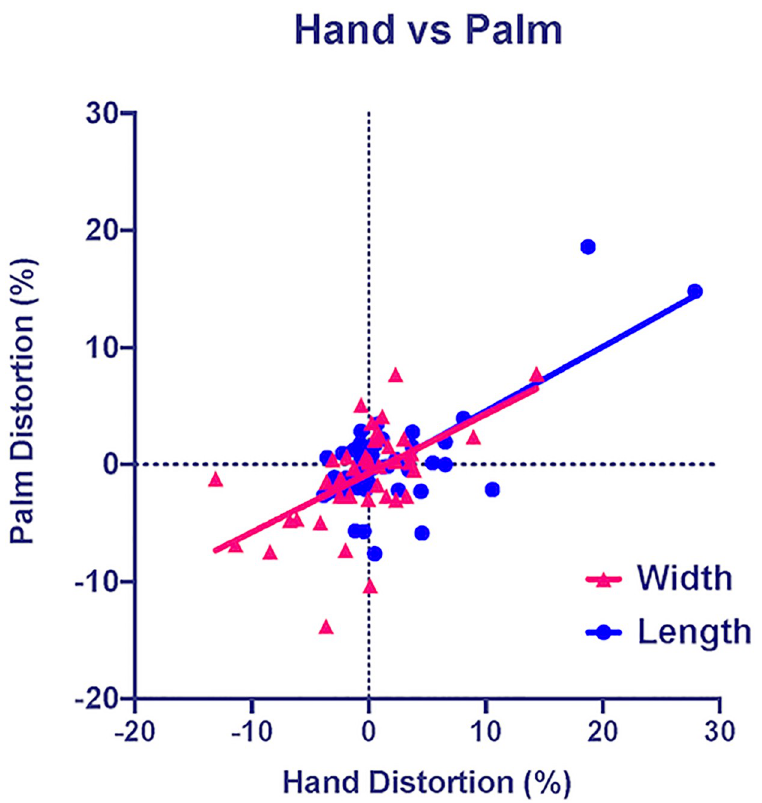
Fig 4. Dorsum vs palm. Relationship between dorsum and palm distortions for width (pink triangles) and length (blue circles). The lines plotted through the data are the goodness-of-fit lines for the width and